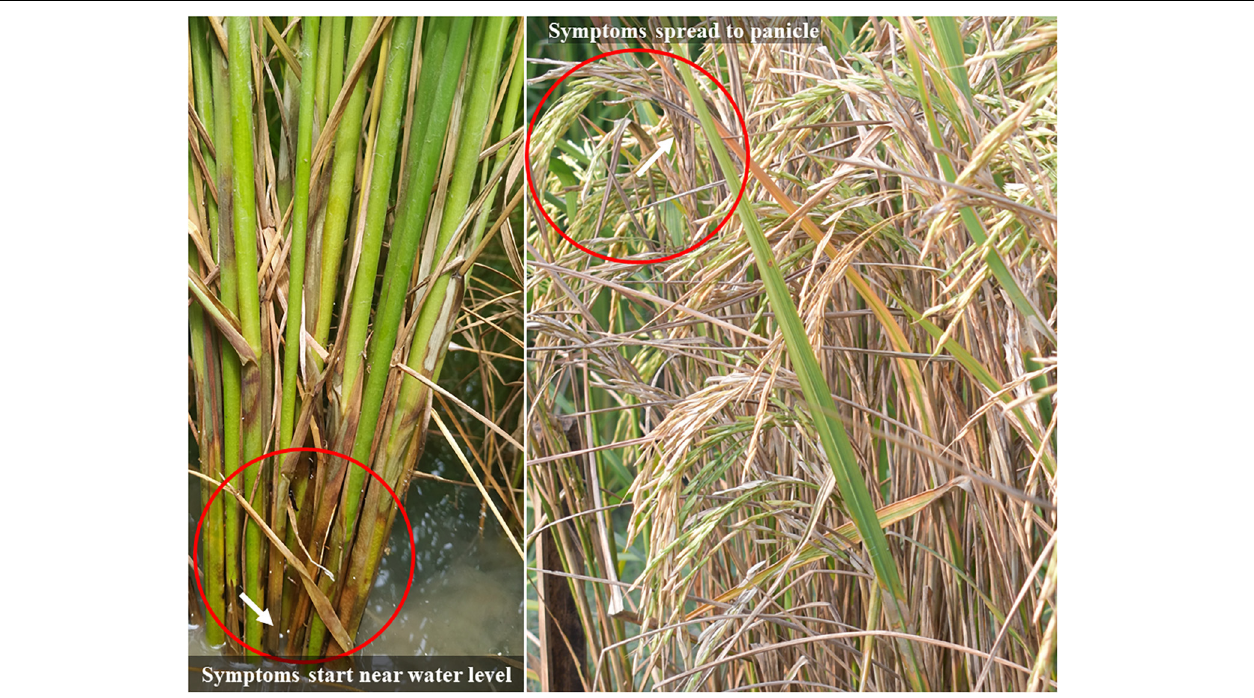
FIGURE 1 | Symptom of sheath blight disease in rice; left side shows the initial symptoms appear on leaf sheath starting from water level, and the right side shows the disease spread up to panicle.